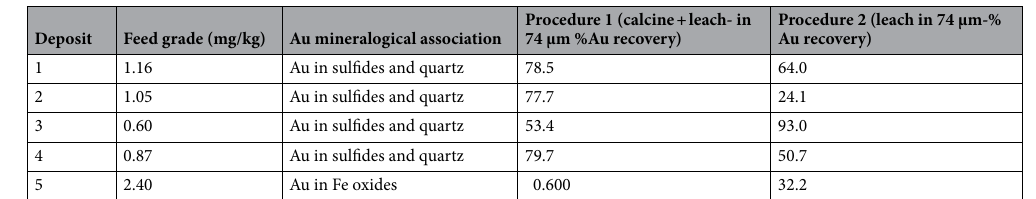
Table 5. Summary of results of metallurgical tests for reuse of